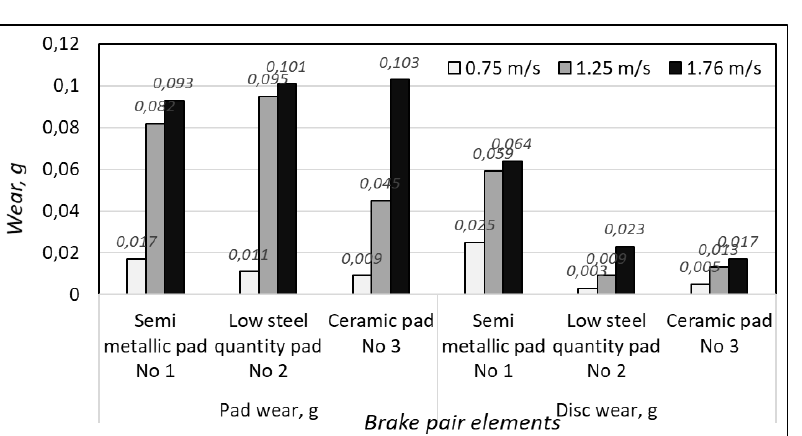
Fig. 3. Brake pad and disc wear during test (0.85 MPa contact